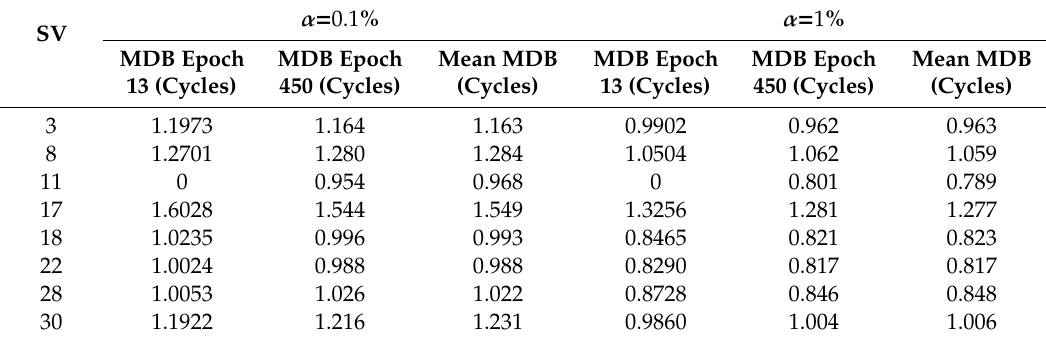
Table 5. MDBs for observable satellites in Dataset